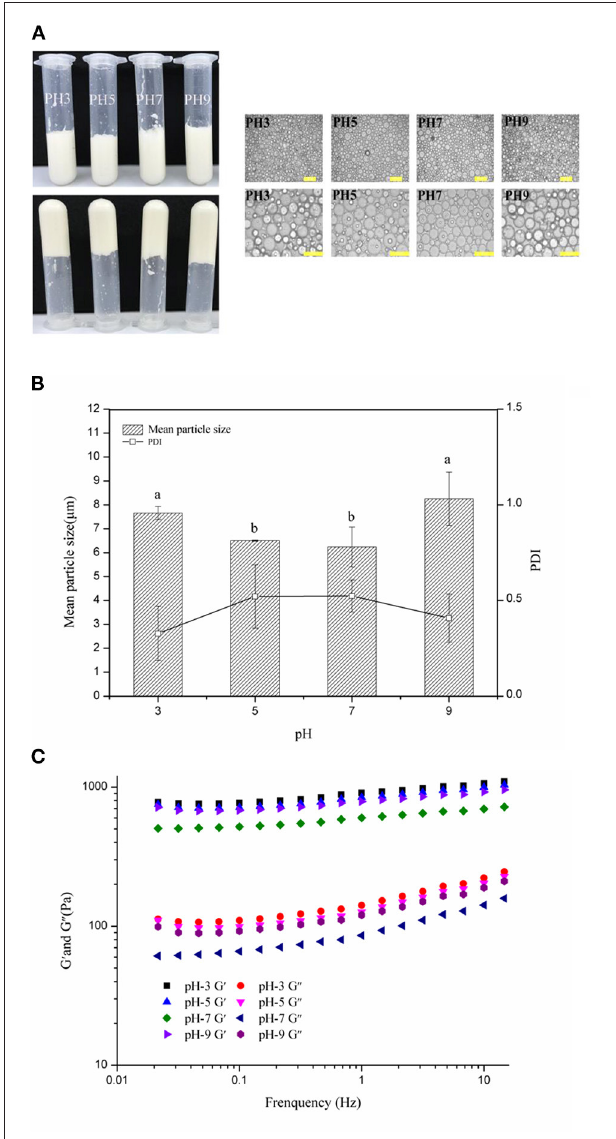
FIGURE 4 | Visual appearance and optical micrographs (A) , mean particle sizes and PDI (B) , frequency sweeps (C) of the WSP-stabilized HIPEs at pH values of 3–9. Different letters (a, b) in the same column indicate significant differences ( p <